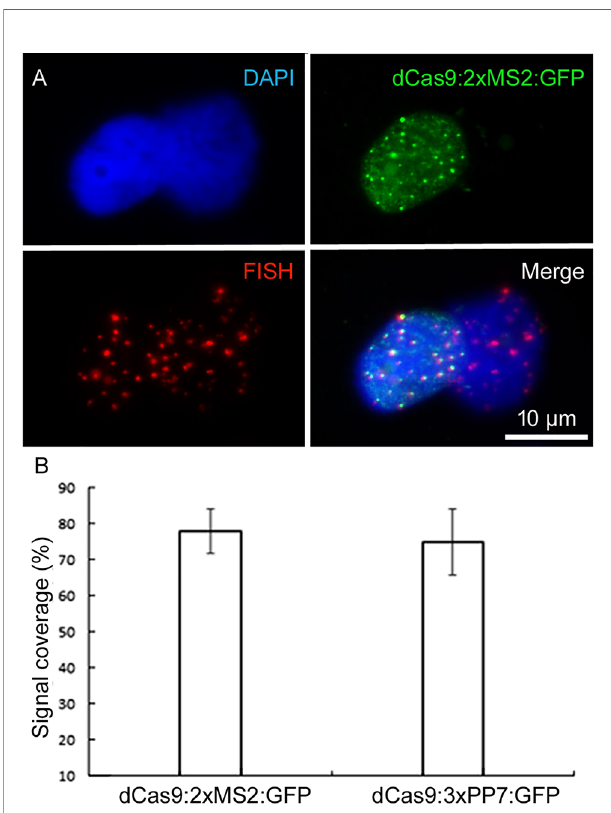
FIGURE 4 | Con fi rming the target speci fi city of aptamer-based CRISPR imaging. (A) Immuno fl uorescence staining against dCas9:2xMS2:GFP combined with telomere-speci fi c FISH. Nuclei are counterstained with DAPI (in blue). (B) Comparing the ef fi ciency of both types of aptamer-based CRISPR imaging with FISH. Telomeric signals based on 20 isolated nuclei per each construct after ImmunoFISH. dCas9:2xMs2:GFP and dCas9:3xPP7:GFP recognized 78% and 75% of telomere signals identi fi ed by FISH, respectively (p < 0.05).